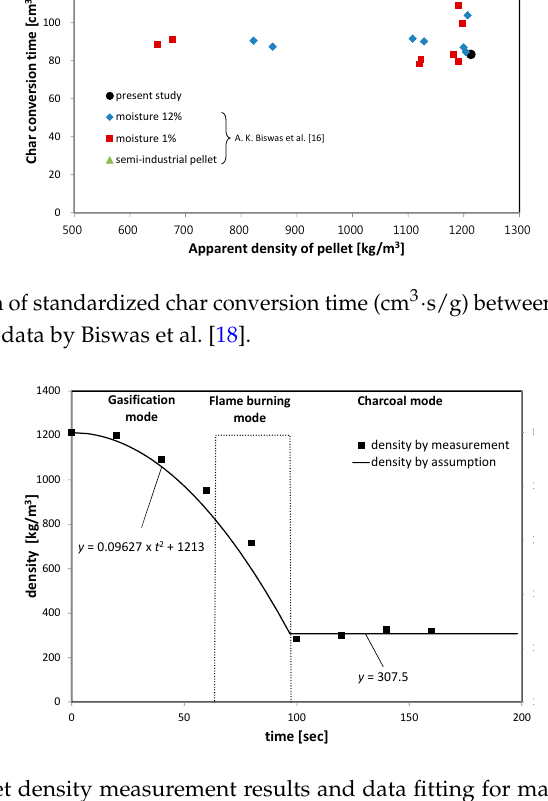
Figure 12. Wood pellet density measurement results and data fitting for mass calculation of wood pellet at each